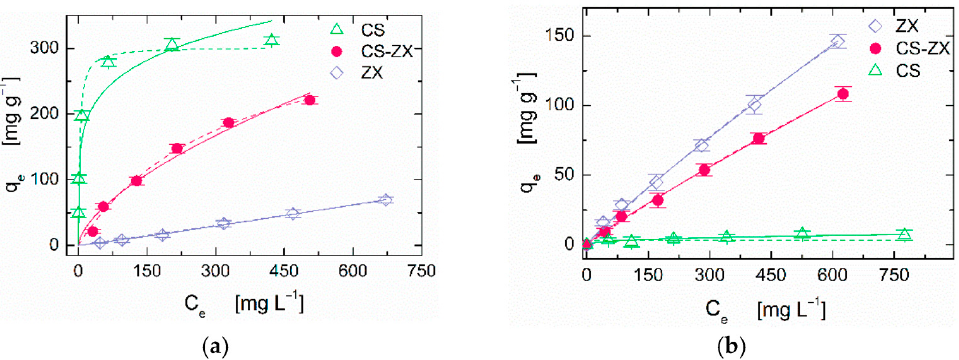
Figure 3. ( a ) IC and ( b ) MB adsorption isotherms of ZX powder and CS, CS–ZX aerogels. Solid lines and dashed lines represent the best fitting of the Freundlich and Langmuir models to the experimental data, respectively (see Section S1 of Supplementary Material for details).